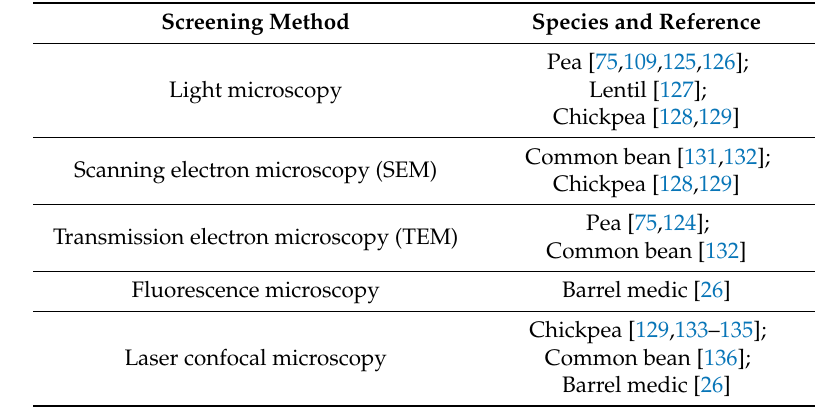
Table 3. Detailed screening methods used for Fusarium wilt disease symptoms analysis in di ff erent legume species.